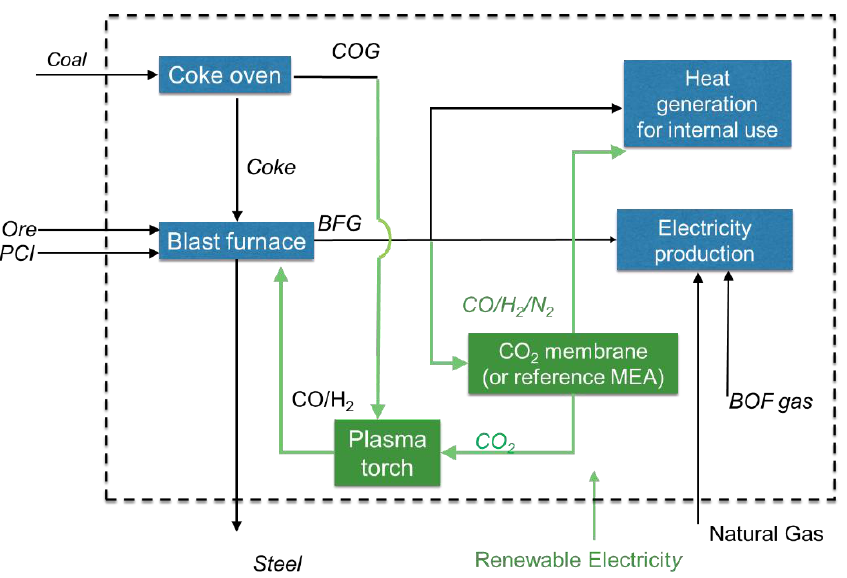
Figure 2. Simplified process schematic for the membrane and reference process.